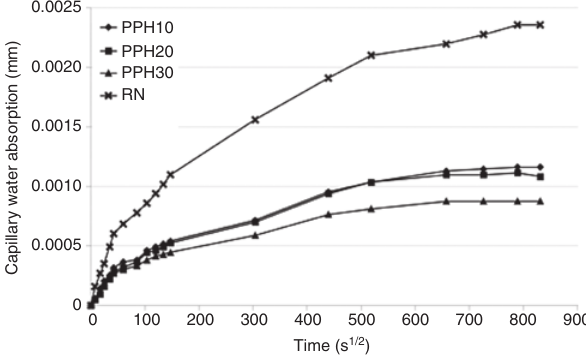
Figure 15 Capillary water absorption of polyvinyl chloride powder containing high strength concretes.